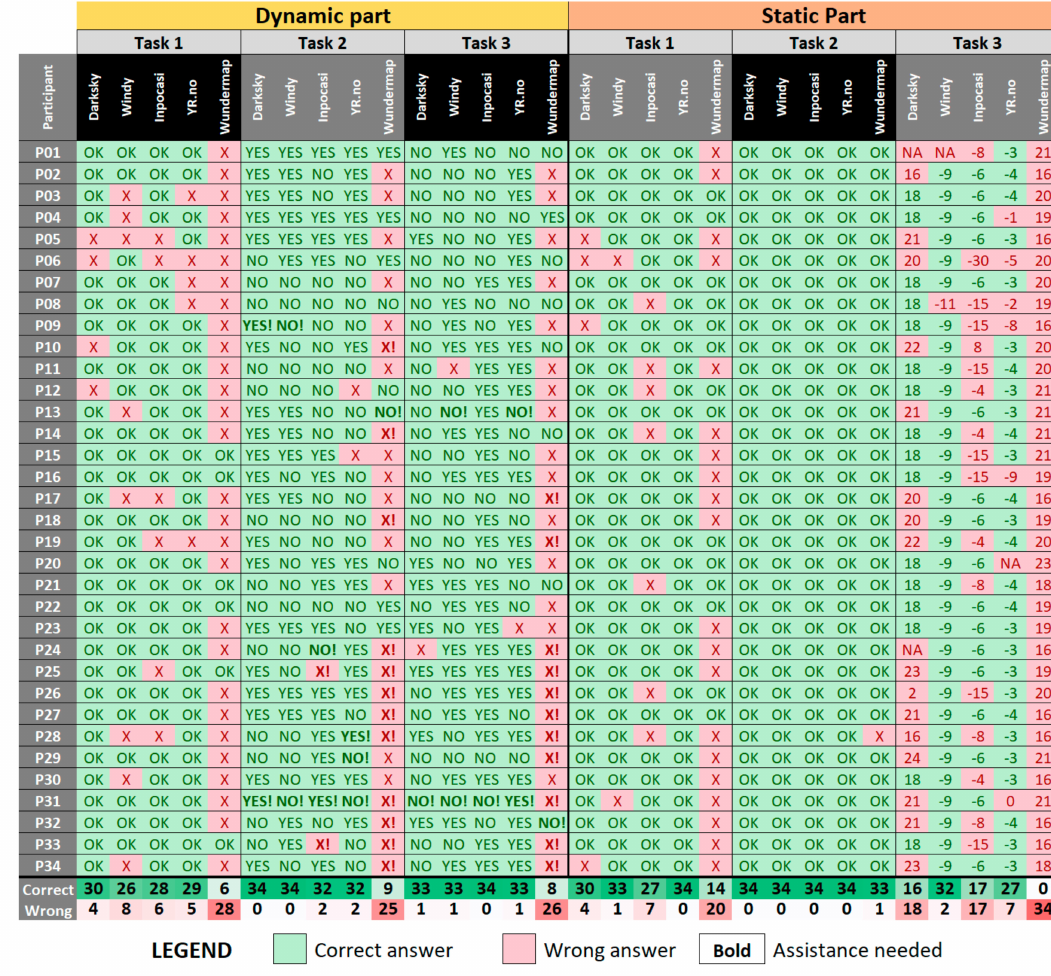
Table 2. Responses to questions and tasks given by the respondents in the dynamic and static sections of the test. Green indicates correct answers, red is incorrect answers, and bold plus exclamation mark indicates answers where a small amount of assistance was